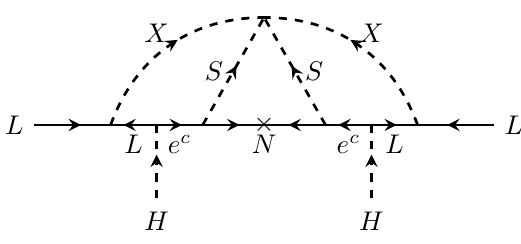
Figure 22 . Neutrino mass diagram for the KNT model in the gauge